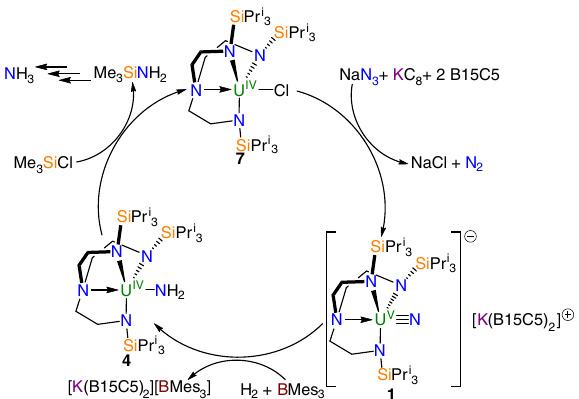
Fig. 8 Reaction cycle for the production of ammonia. Treatment of 7 with sodium azide, KC 8 , and two equivalents of B15C5 produces the terminal uranium-nitride 1 , which in turn reacts with H 2 and BMes 3 to give 4 . Treatment of 4 with Me 3 SiCl, followed by work-up and acidi fi cation steps, as indicated by the multiple arrows, produces ammonia. B15C5 = benzo-15- crown-5 ether. Mes =